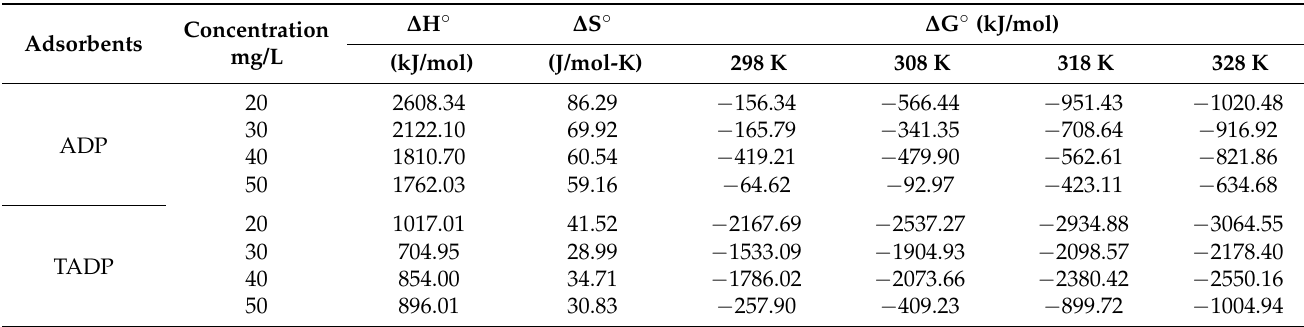
Table 4. Thermodynamic parameters for the adsorption of Cu(II) on ADP and TADP adsorbents (initial concentration, C 0 was 20 mg/L).